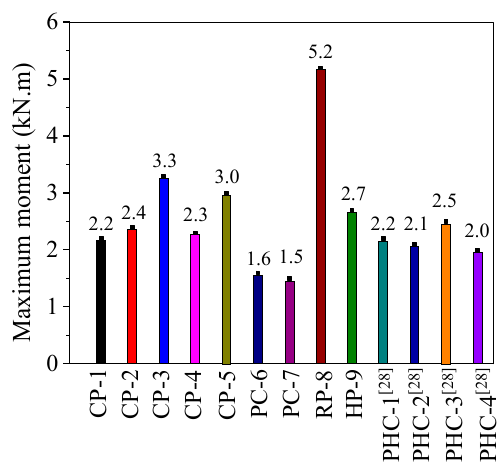
Figure 16. Maximum moments of the piles at 10 mm loading step.